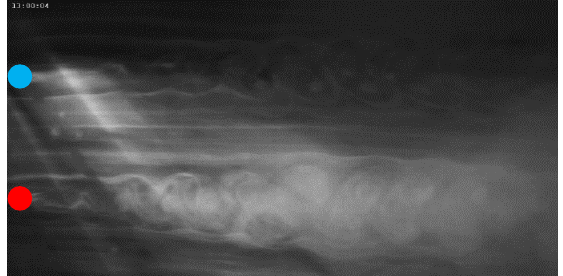
Fig. 6. Von Kármán vortex street for a non-isothermal case. Upper blue point cooled cylinder, lower red point reference cylinder.